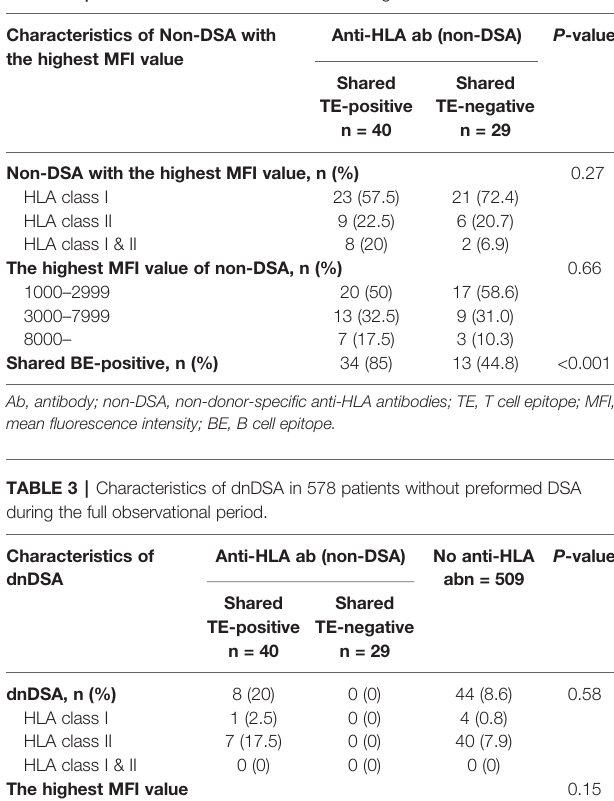
TABLE 2 | Characteristics of non-DSA with the highest MFI.